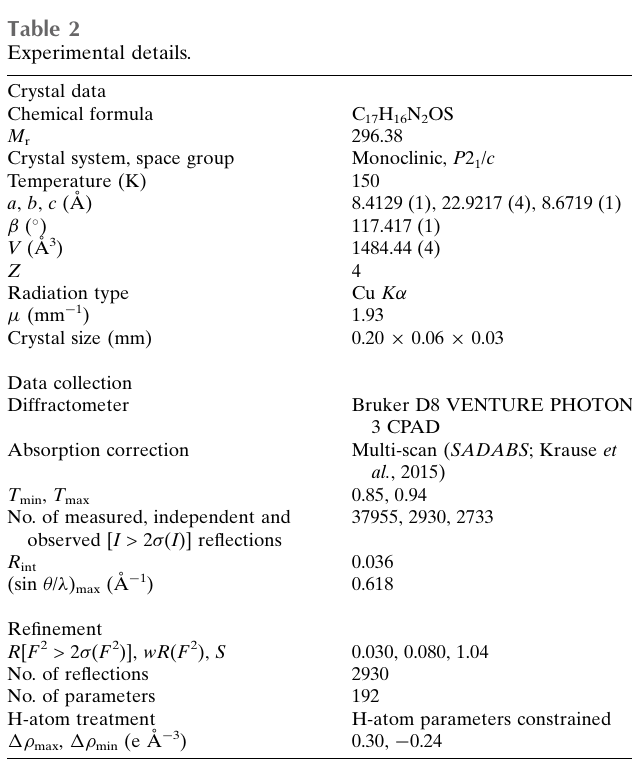
Table 2 Experimental